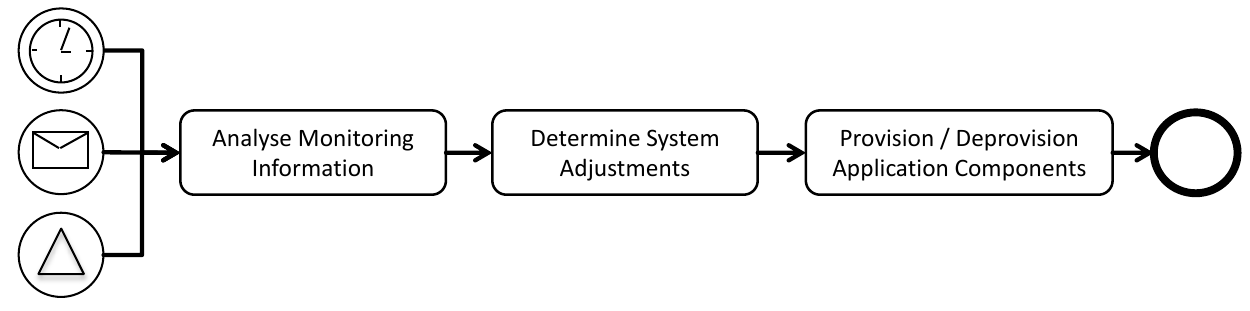
Figure 8. Abstract Management Flow of the Elasticity Management